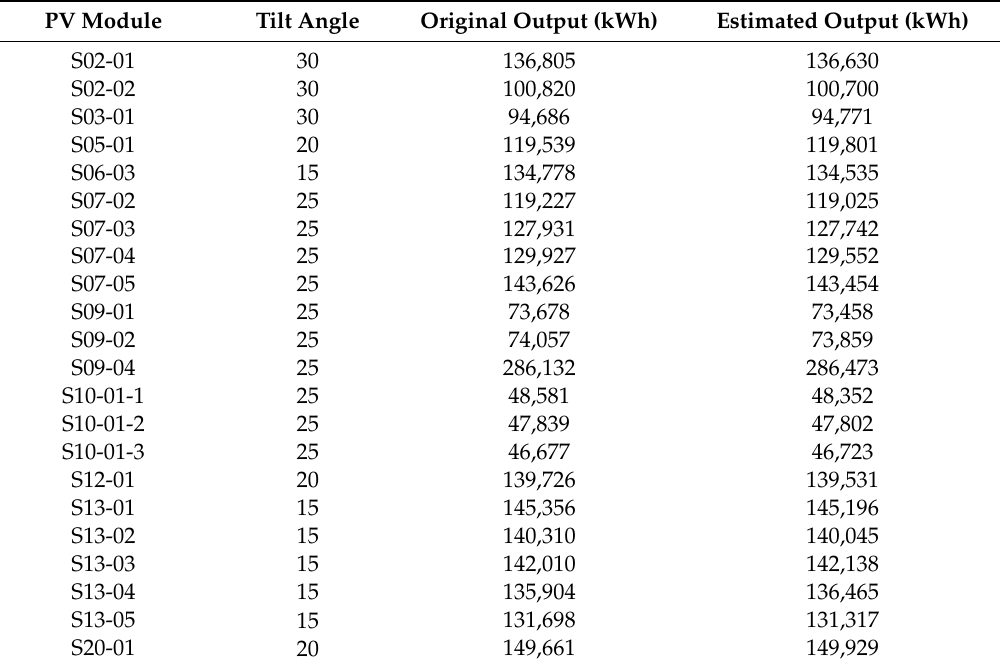
Table 6. Estimation result of the 2017 annual photovoltaic (PV)